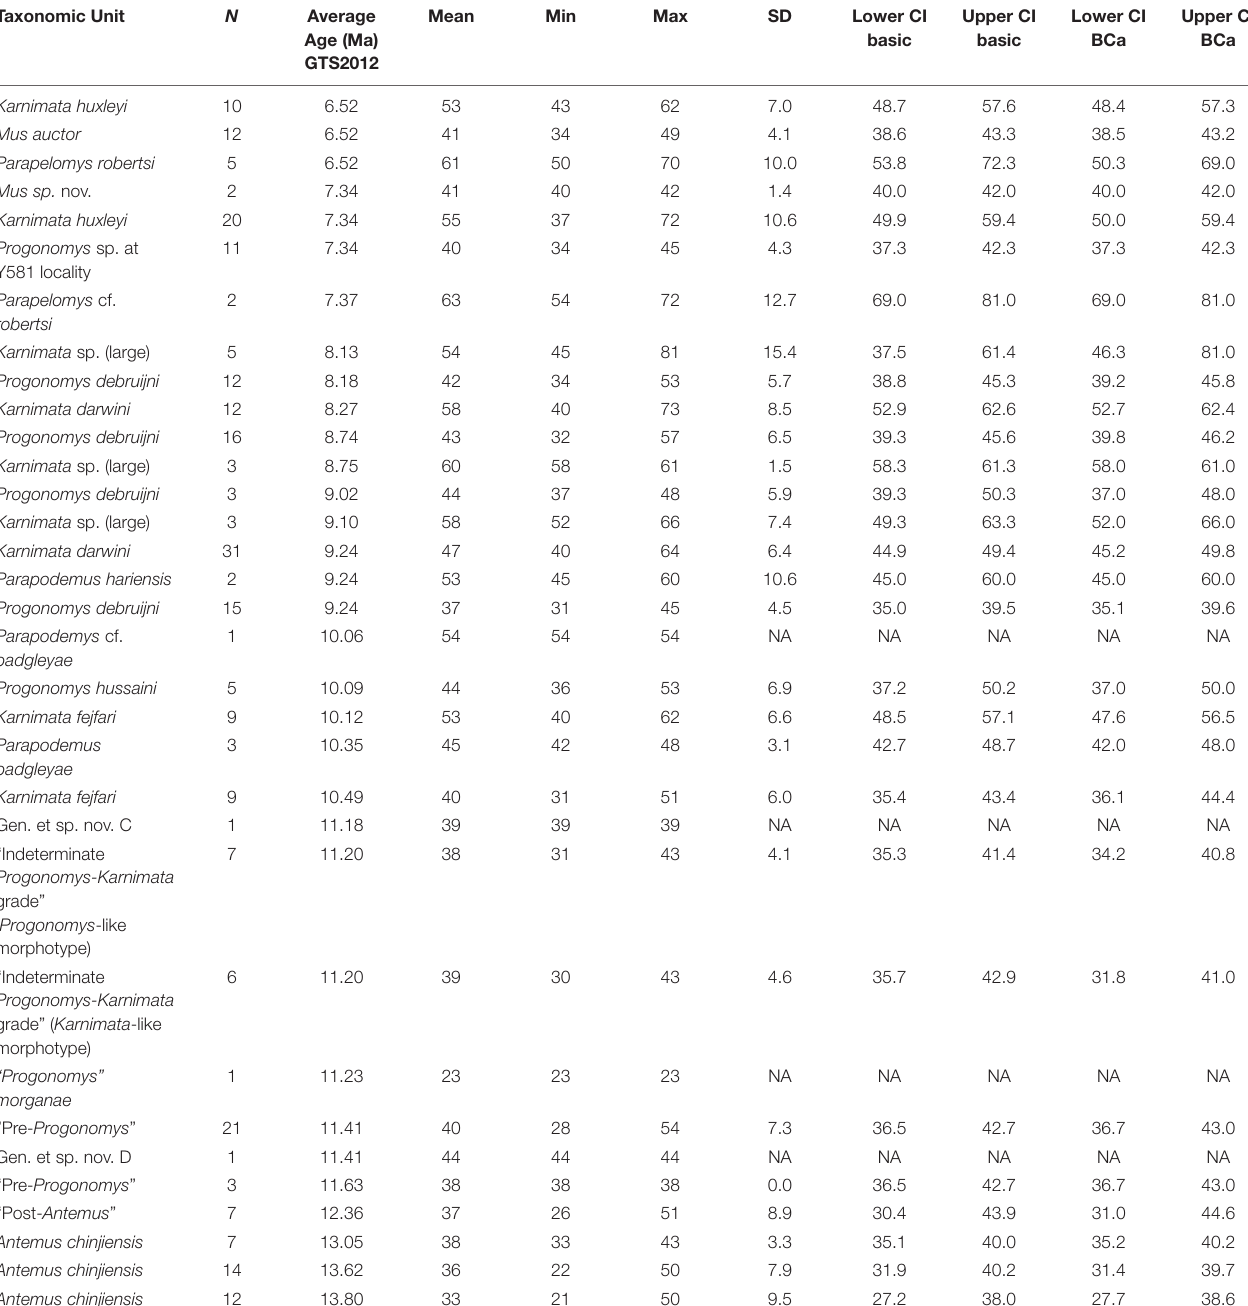
TABLE 3 | Summary statistics for anterostyle angle in Siwalik murine rodents, corresponding to Figure 3B . Taxonomic